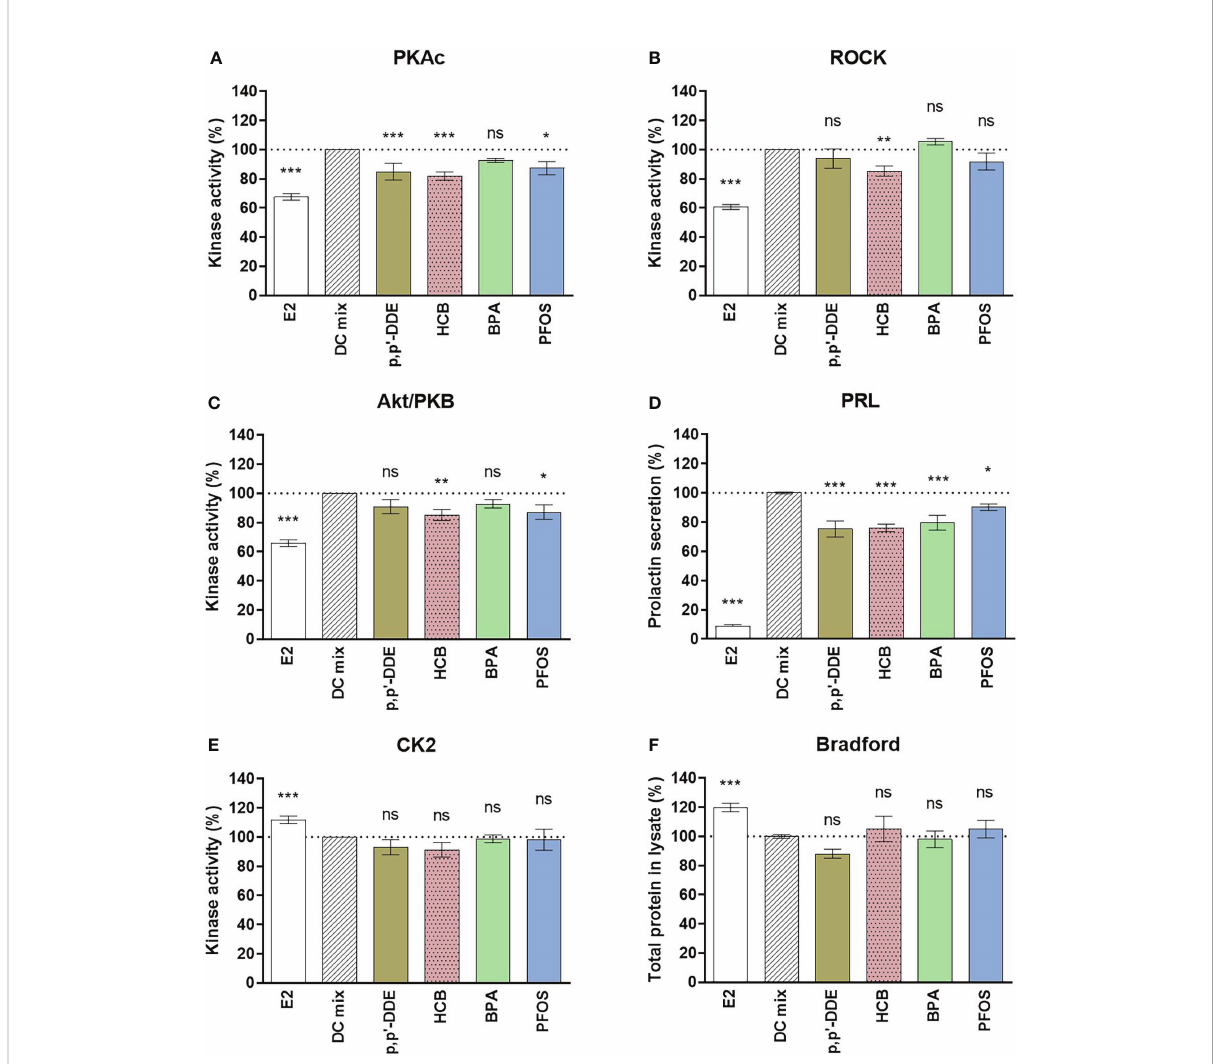
FIGURE 4 Effect of DDE, HCB, BPA and PFOS on decidualization and viability markers. The eSCs of two additional women were exposed to the decidualization-inducing mixture (DC-mix) in the absence or presence of 1 µM DDE, HCB, BPA, PFOS for 9 days. The effects of EDCs were compared to the positive control DC-mix, and 10 nM E2 was used as negative control. Total protein concentration for different treatments was normalized after lysis of the eSCs. Protein kinase activity for (A) PKAc, (B) ROCK2 and (C) Akt/PKB was assessed in lysates using a competitive photoluminescent probe displacement assay and calculated as percentage of DC-mix (100%). (D) Secreted PRL was measured in media aliquots (collected following the last 72 h of the in vitro treatment) using a human PRL ELISA kit. The impact of the exposures on viability of the endometrial stromal cells in culture during decidualization assays was assessed by the activity of the viability marker kinase CK2 in lysates (E) as well as evaluating the total protein concentrations in lysates at the end of the assay (F) . Values are expressed as mean percentage of